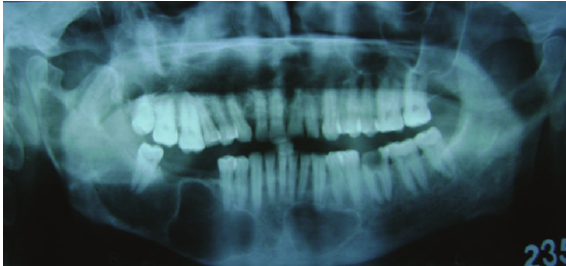
Figure 4: Panoramic radiograph showing cystic lesions in the